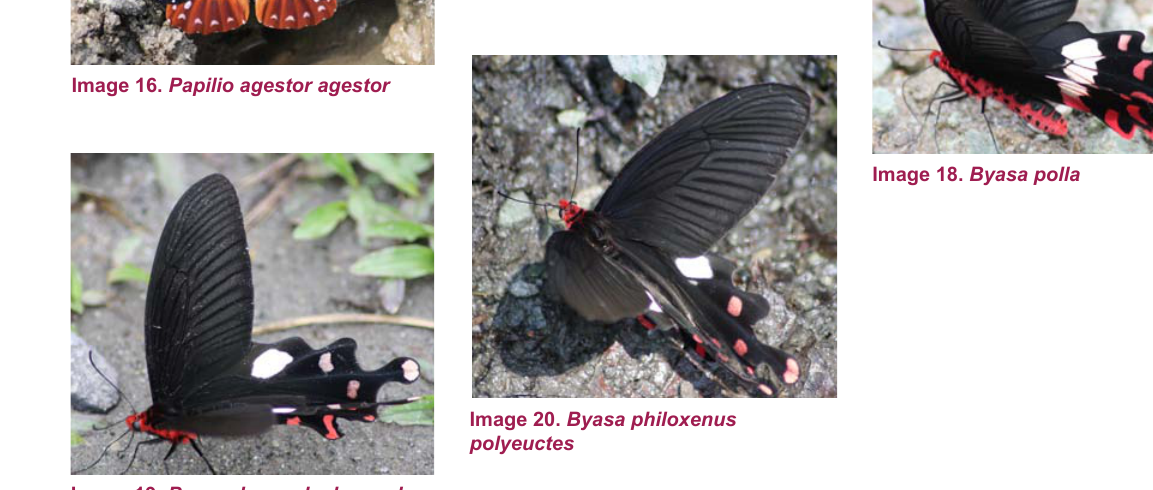
Image 17. Papilio epycides epycides